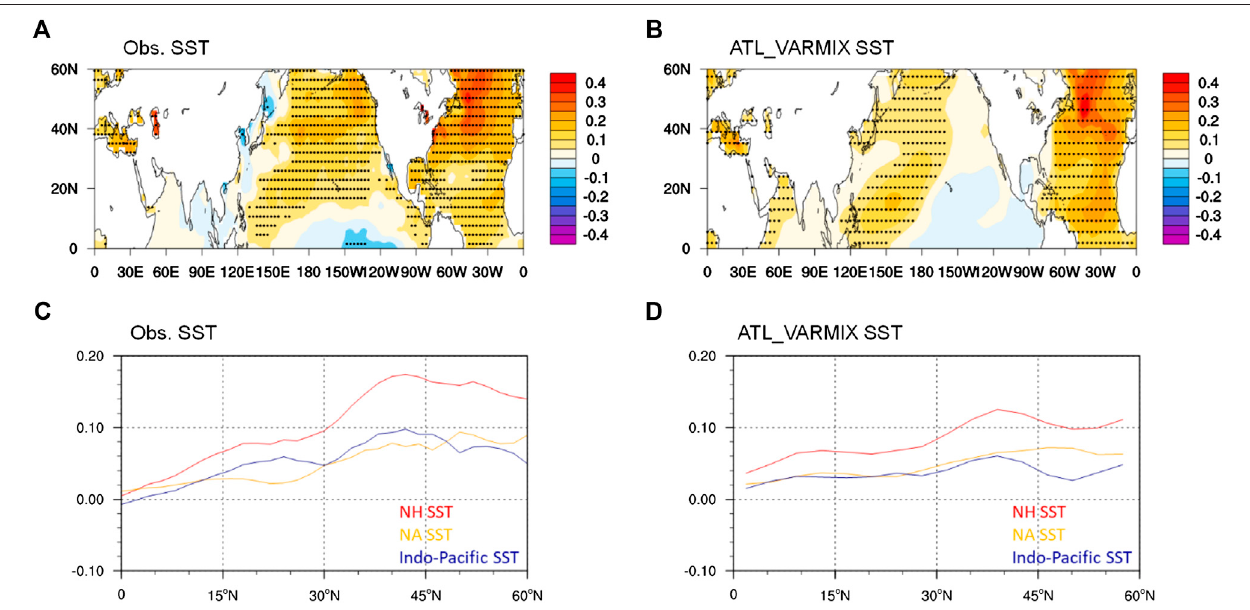
FIGURE 8 | The anomalous SST (K) regressed on the normalized AMV index derived from the (A) ERSST dataset and the (B) ATL_VARMIX experiment for the period 1900 – 2013. The SST over the North Atlantic is prescribed with monthly-varying SSTs from the HadISST data. Dotted shading in (A) and (B) indicates the regressioncoef fi cientssigni fi cantatthe95%con fi dencelevel.ThezonalmeanSSTanomalies(K)oftheNorthernHemisphere(redlines),NorthAtlantic(yellowlines),and Indo-Paci fi c (blue lines) are derived from the (C) ERSST dataset and the (D) ATL_VARMIX experiment.